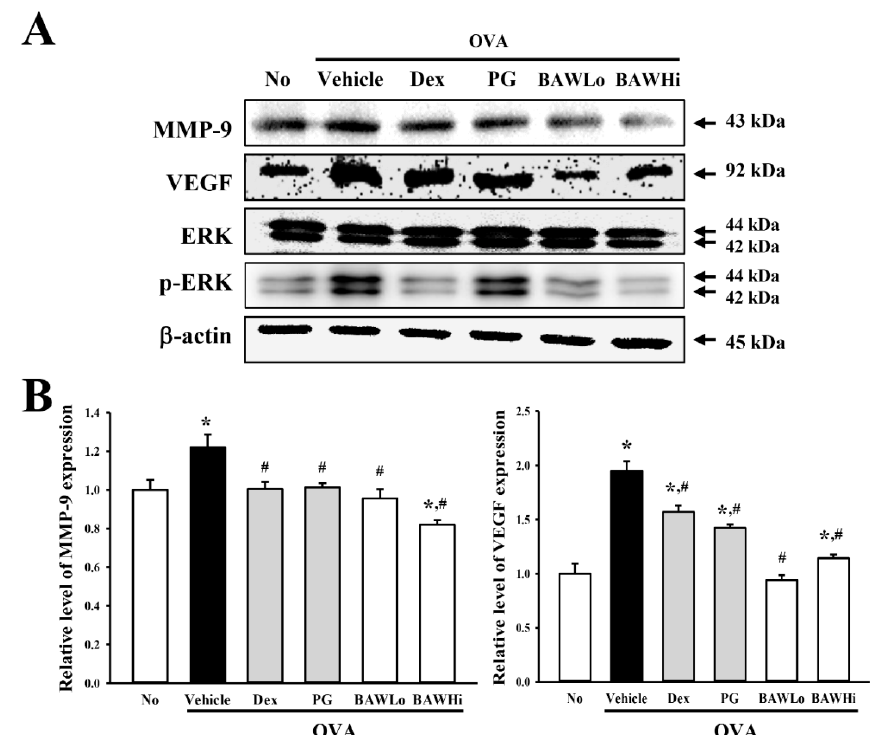
Figure 6. Level of airway remodeling-related factors. ( A ) The expression level of MMP-9 in lung tissue of the OVA + BAW-treated model was measured using specific antibodies. Moreover, changes in the expression of VEGF and the regulator protein under the signaling pathway downstream of VEGF were also examined in lung tissue of a subset group using specific antibodies. ( B ) Band intensities